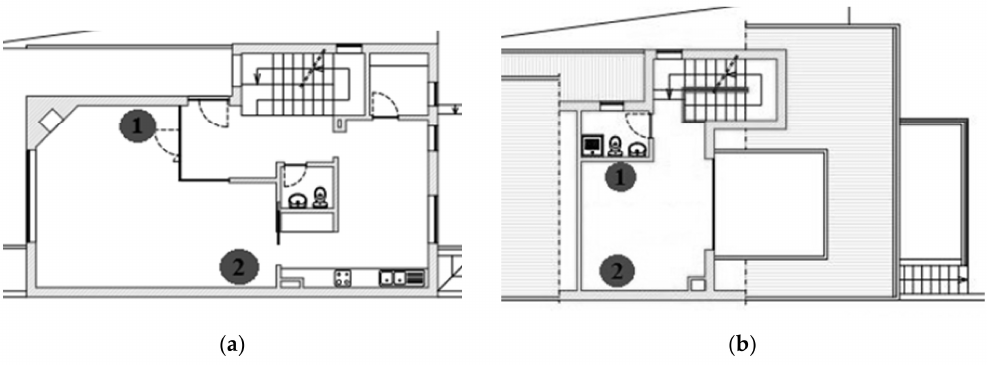
Figure 1. Case study and location of the sensors: ( a ) Living room; ( b ) Bedroom. Table 1. Case study. Geometric characterization.